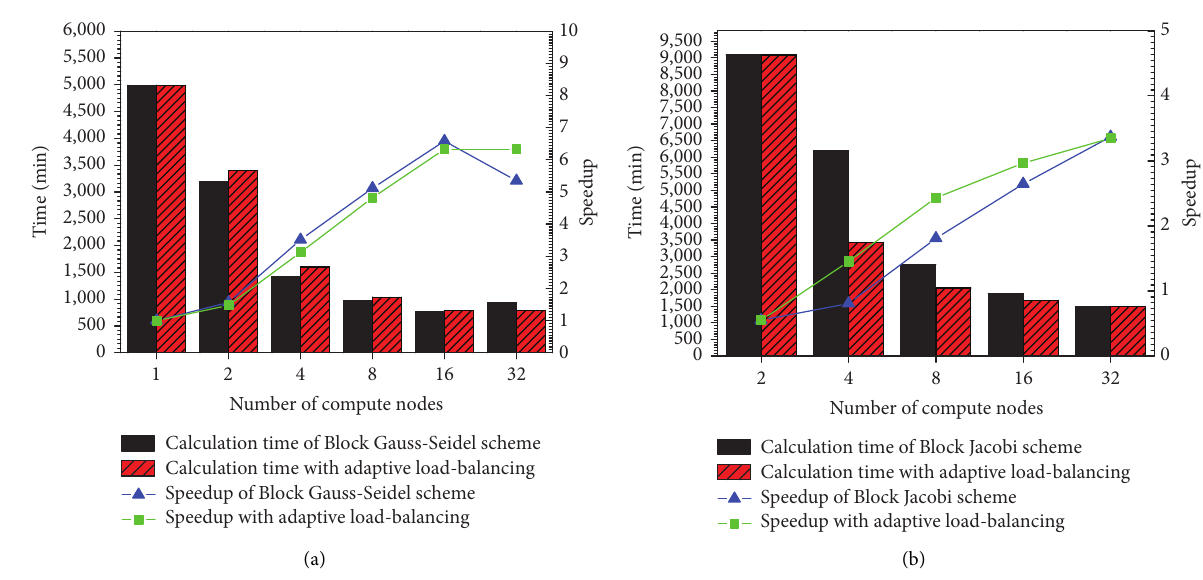
Figure 11: Total running time and speedup of the two schemes for the 3x3 fuel pin example with different number of compute nodes. (a) Block Gauss–Seidel scheme. (b) Block Jacobi